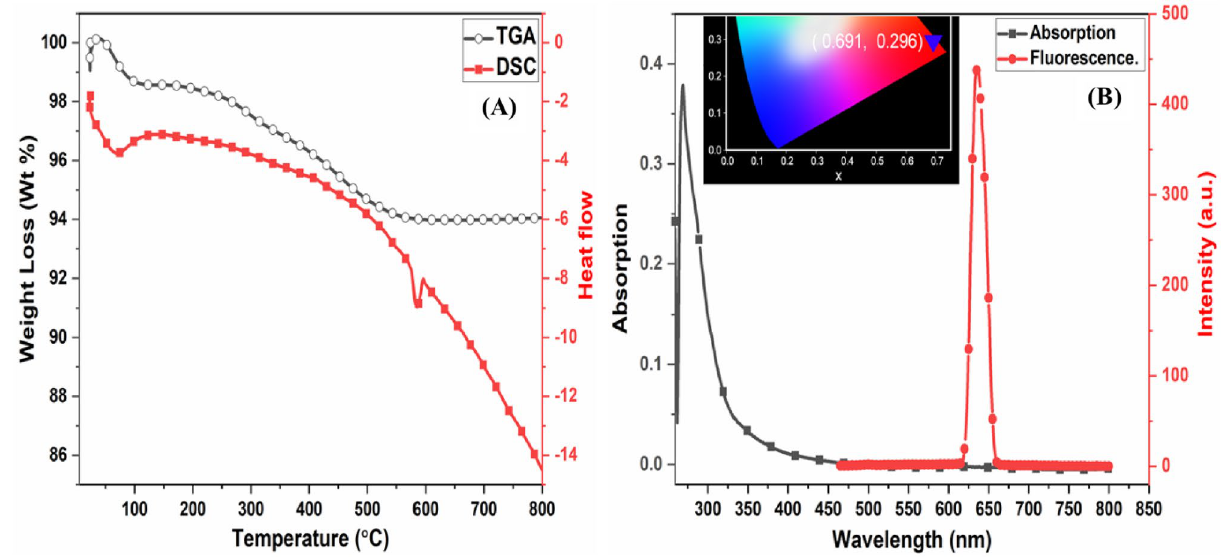
Figure 3. ( A ) TGA-DSC spectra, ( B ) Uv- visible spectrum, emission spectrum at λ exc. 320 nm, and the inset photo shows the CIE diagram of